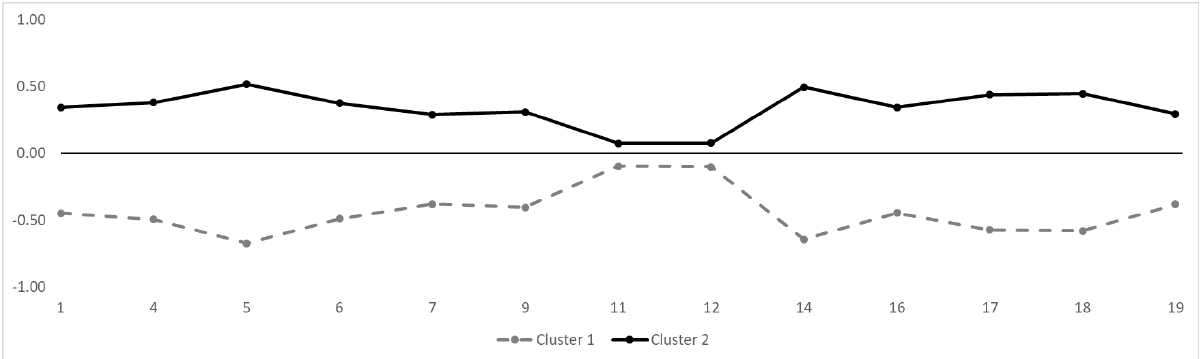
Figure 2. Cluster distribution of the 13 DBI-S items. The Y-axis indicates the z-standardized mean per item. The X-axis shows the item numbers.